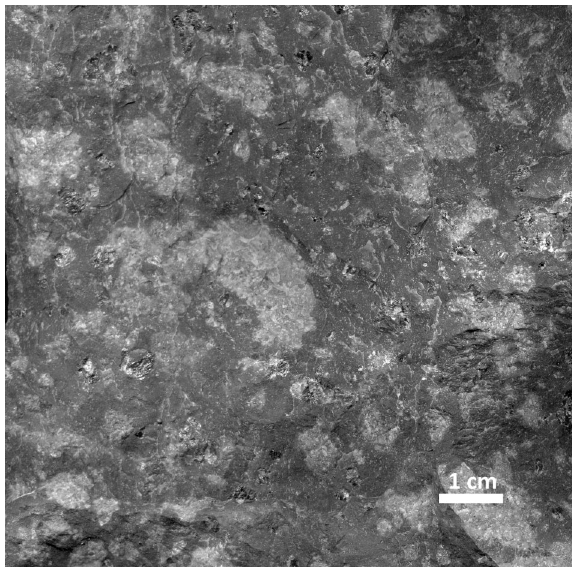
Fig. 2. Suursaari quartz porphyry: quartz and orthoclase pheno- crysts (light) in aphanitic groundmass (dark). Sample S-32, M(cid:228)kiinp(cid:228)(cid:228)llys.